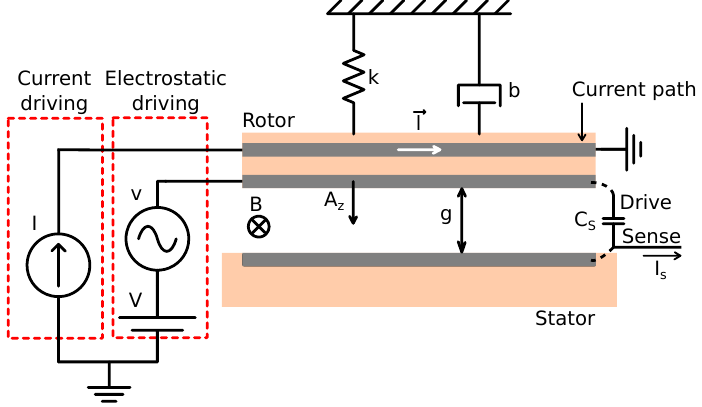
Figure 1. MEMS electromechanical model simplified